Question: Write the caption for this figure.
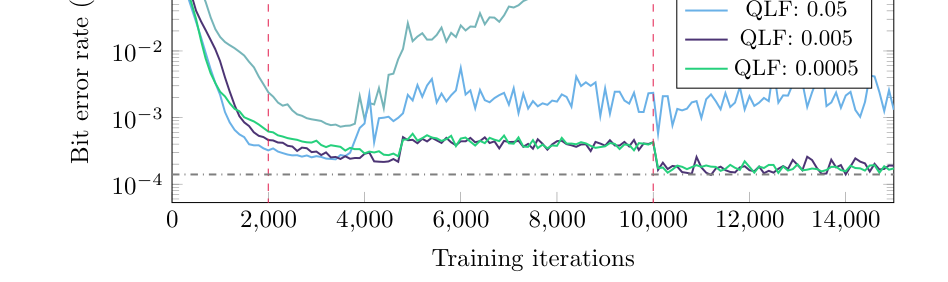
Answer: Course of the BER during the three phases of quantized training for diﬀerent QLFs. The BER of the full precision model is given by the gray horizontal line.